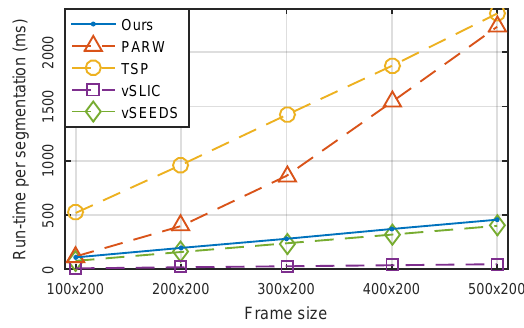
Figure 7. Comparison of